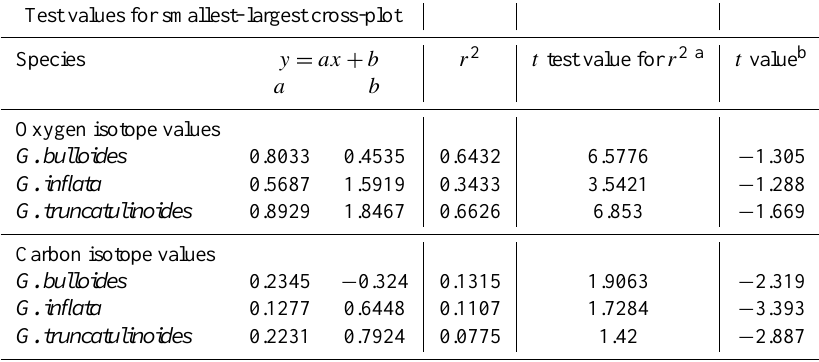
Table 2. Smallest and largest size fraction linear regression and t -test values. Test values for smallest–largest cross-plot Species y = ax + b r 2 t test value for r 2 a t value b a b Oxygen isotope values G. bulloides 0.8033 0.4535 0.6432 6.5776 − 1.305 G. inflata 0.5687 1.5919 0.3433 3.5421 − 1.288 0.8929 Carbon isotope values